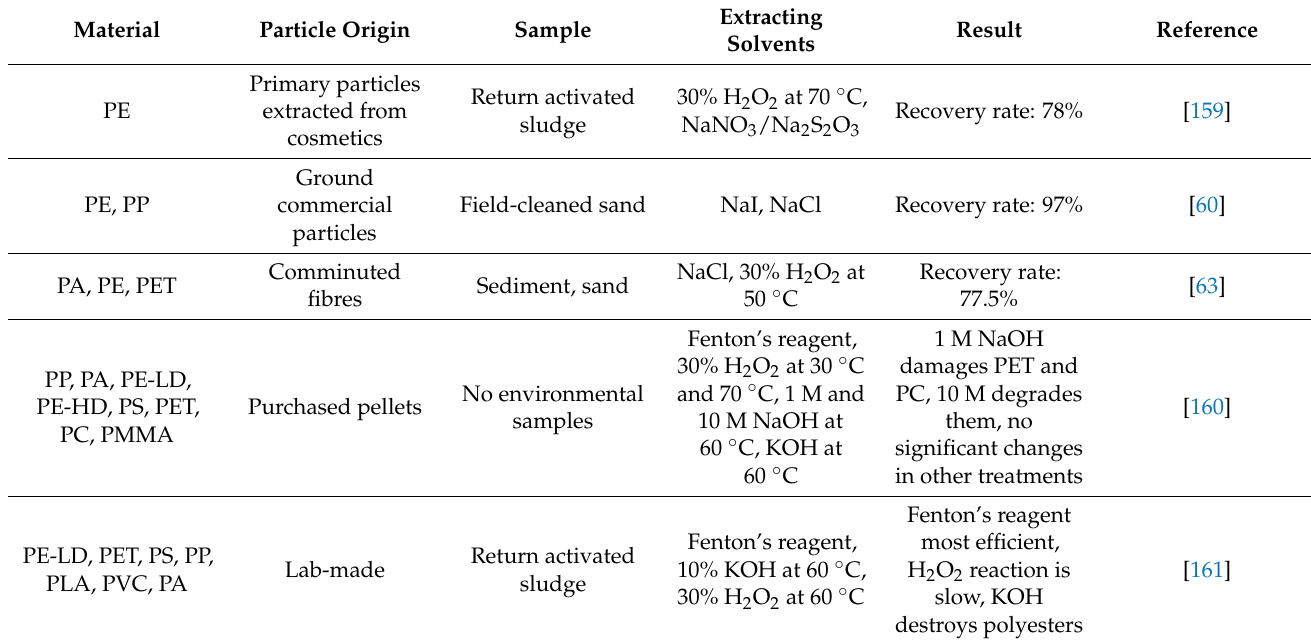
Table 3. Extraction protocols and recovery experiments conducted in selected